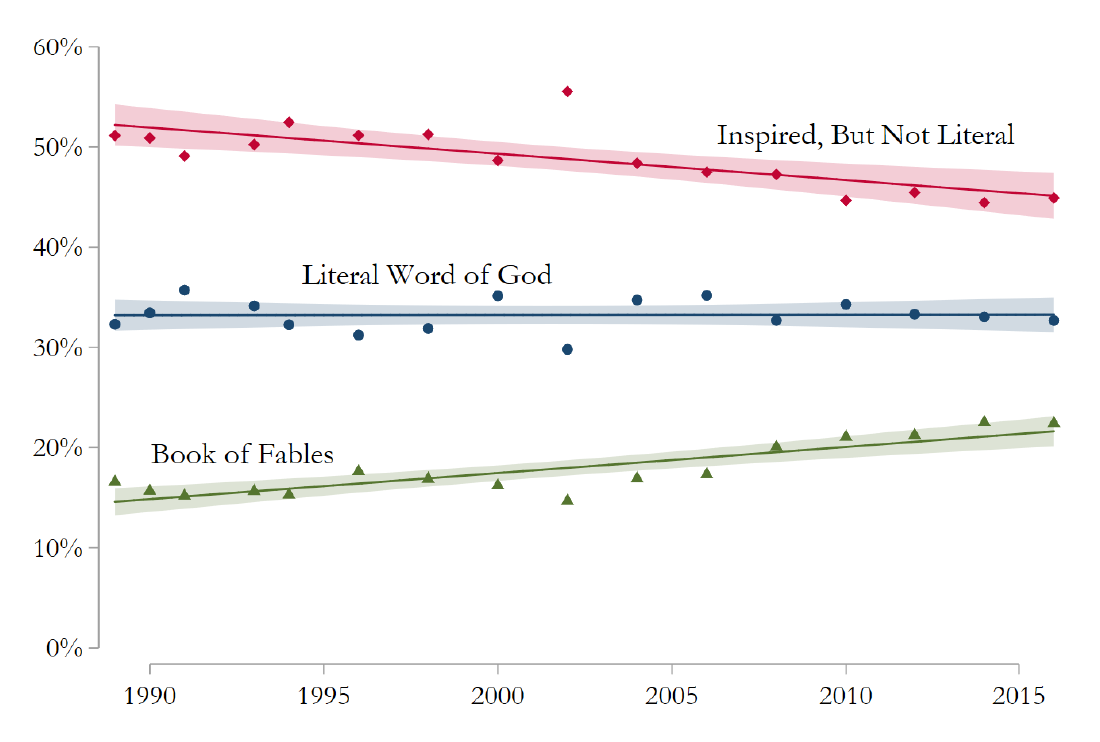
Figure 4: View of Bible over time, General Social Survey. Source: General Social Survey, 1989 to 2016. Note: The GSS question asks which of the three views toward the Bible presented in the figure comes closest to their own. Those who volunteered responses other than the three given were excluded from this